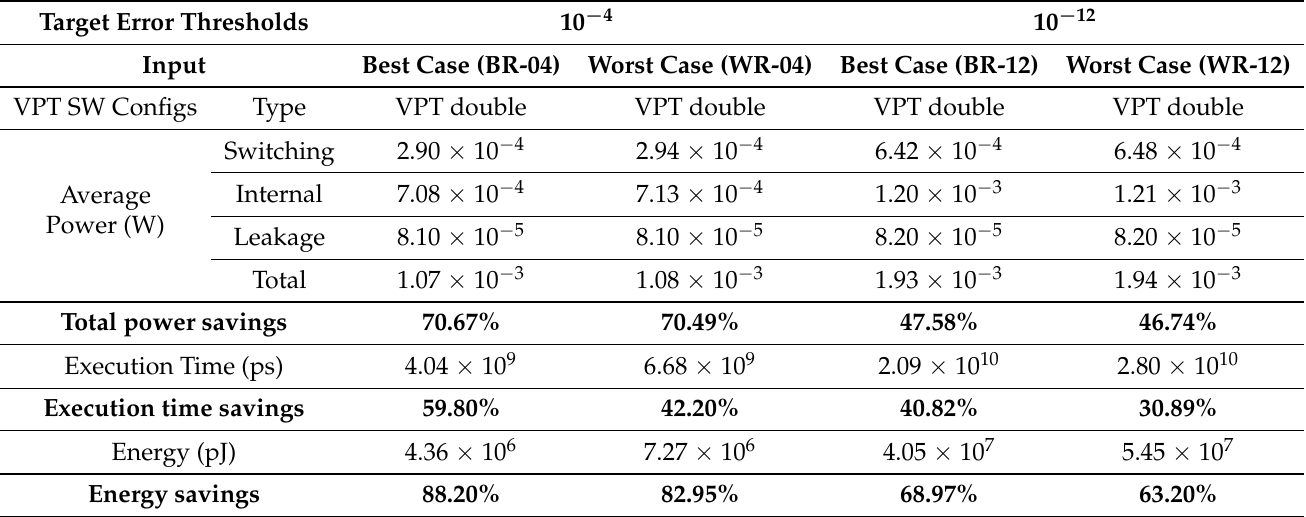
Table 6. Power, execution time, and energy consumption gains of VPT-enabled version of Jacobi (with relaxed thresholds and SMI = 4) executed on the VPT_H configuration of the VPT-FPU. Target Error